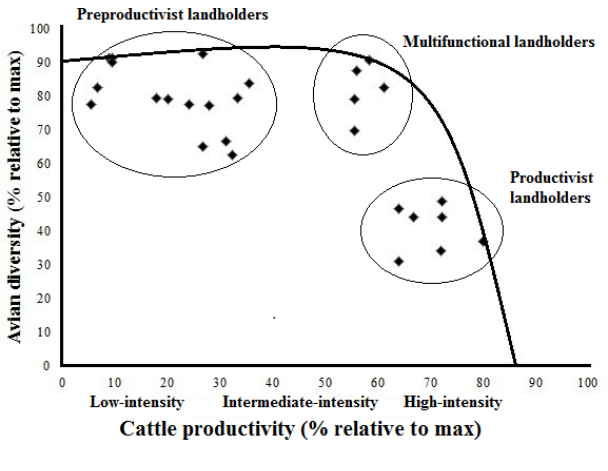
Fig. 1 . Efficiency frontier for combinations of avian diversity and agricultural productivity in Dry Chaco agricultural frontiers (modified from Mastrangelo and Gavin